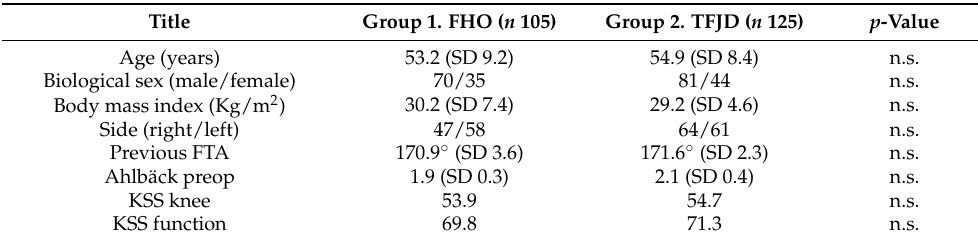
Table 1. Demographic data, preoperative KSS knee and function, femorotibial angle (FTA) and Ahlbäck scale.